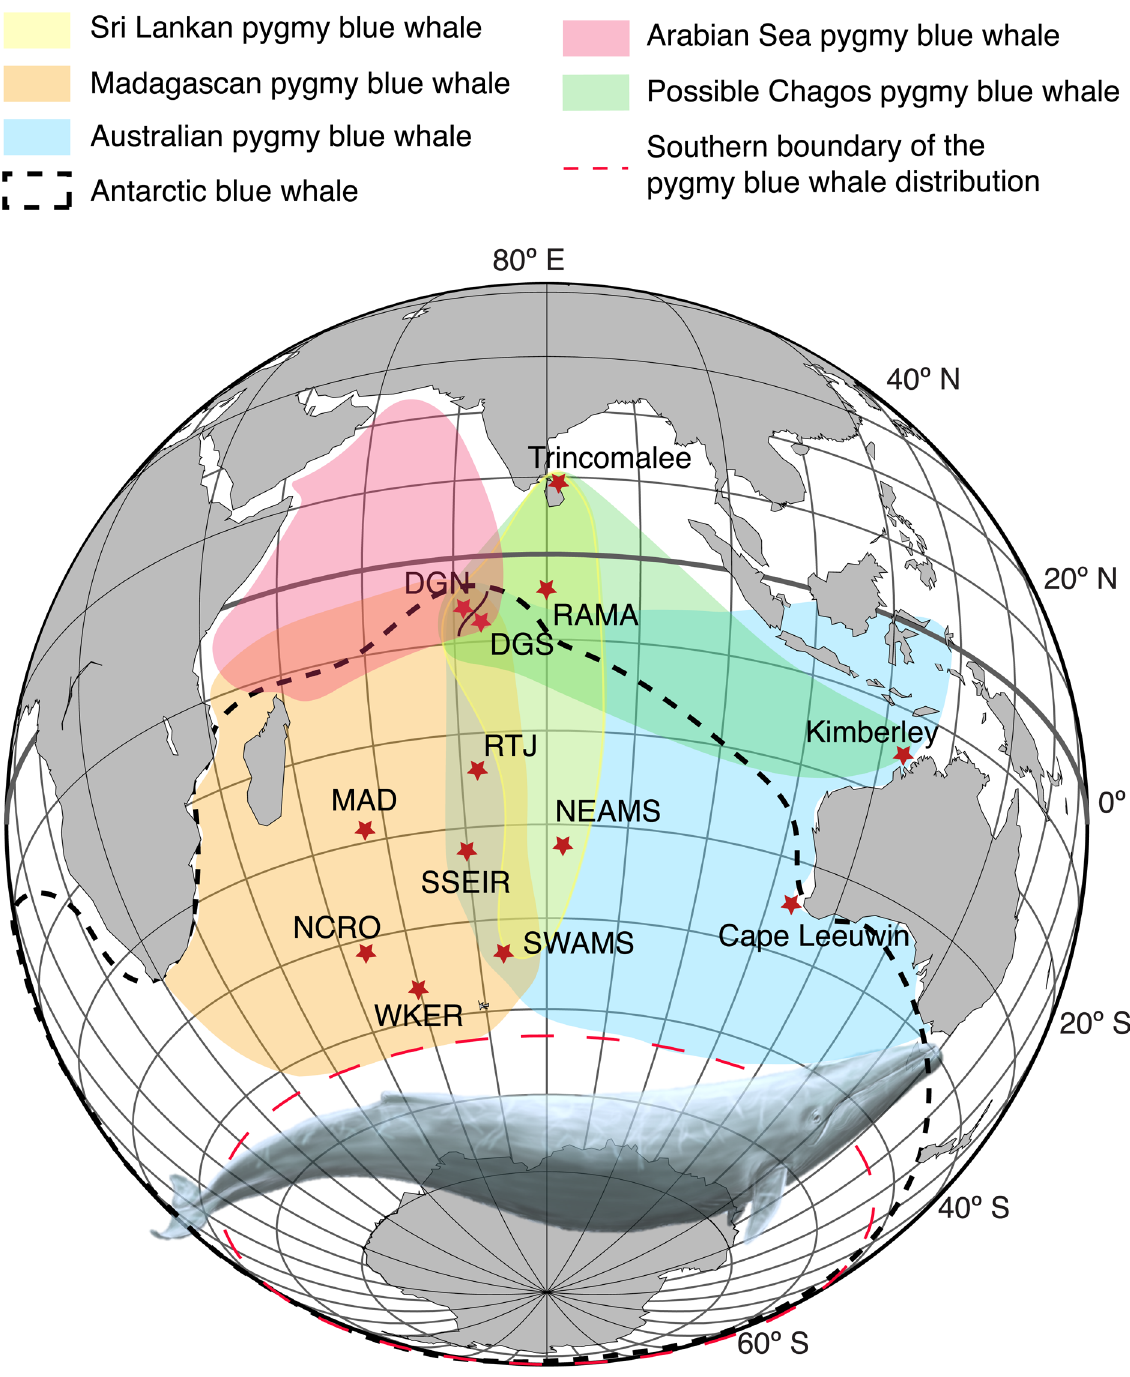
Figure 11. Distribution of the five blue whale acoustic populations of the Indian Ocean: the Sri Lankan—NIO (yellow); Madagascan—SWIO (orange); Australian—SEIO (blue); and Arabian Sea—NWIO (red) pygmy blue whales; the hypothesised Chagos pygmy blue whale (green); and the Antarctic blue whale (black dashed line). These distributions have been inferred from the acoustic recordings conducted in the area ( e.g. , 7–9,11,13,21,50,51 , and E.C.L personal observations). The long-term recording sites used to infer these distribution areas are indicated by red stars. The map was generated with GMT 52 . Blue whale illustration by Alicia